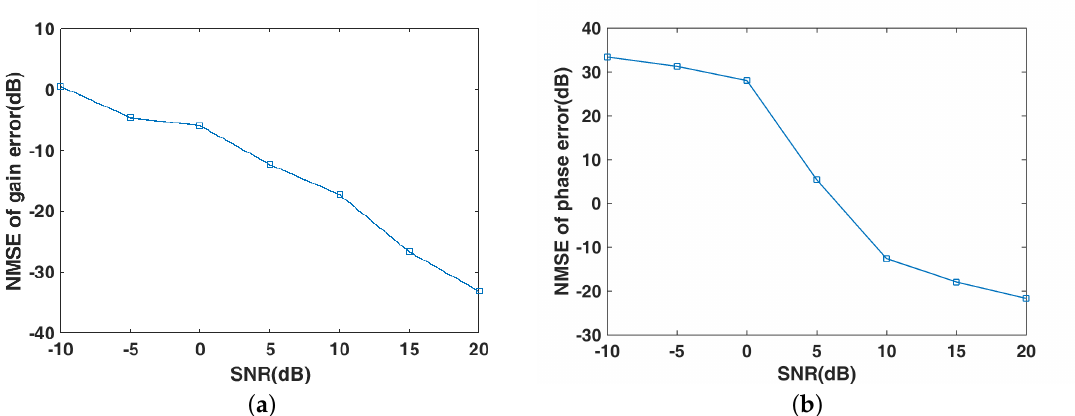
Figure 10. gain–phase error estimation performance under different SNRs ( a ) NMSE of gain error estimation; ( b ) NMSE of phase error